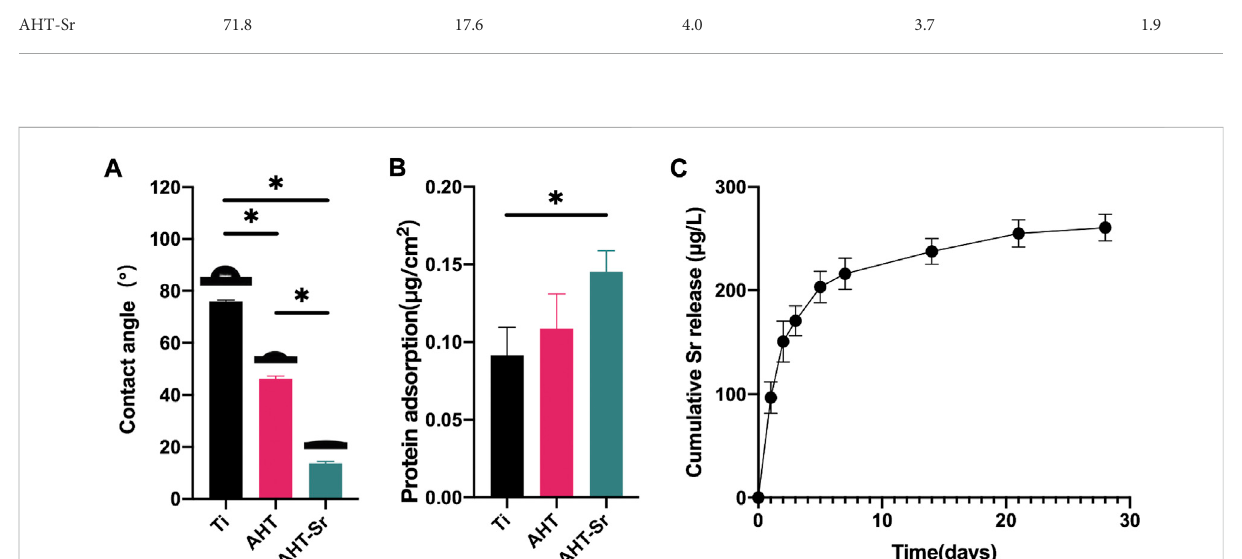
FIGURE 2 Surface physicochemical properties of Ti, AHT, and AHT-Sr. (A) Measurement of water contact angles in various specimens ( n = 3). (B) Protein adsorption assay. (C) Cumulative release pro fi le of Sr 2+ ions from AHT-Sr within 28 days after incubation in PBS. The results are presented as the mean ± SD, n = 3, * p <